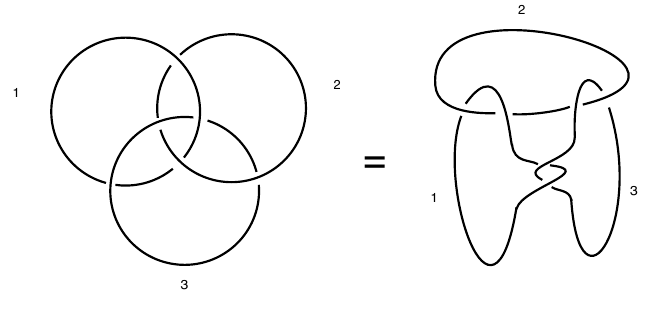
Figure 13 . The three component link 6 3